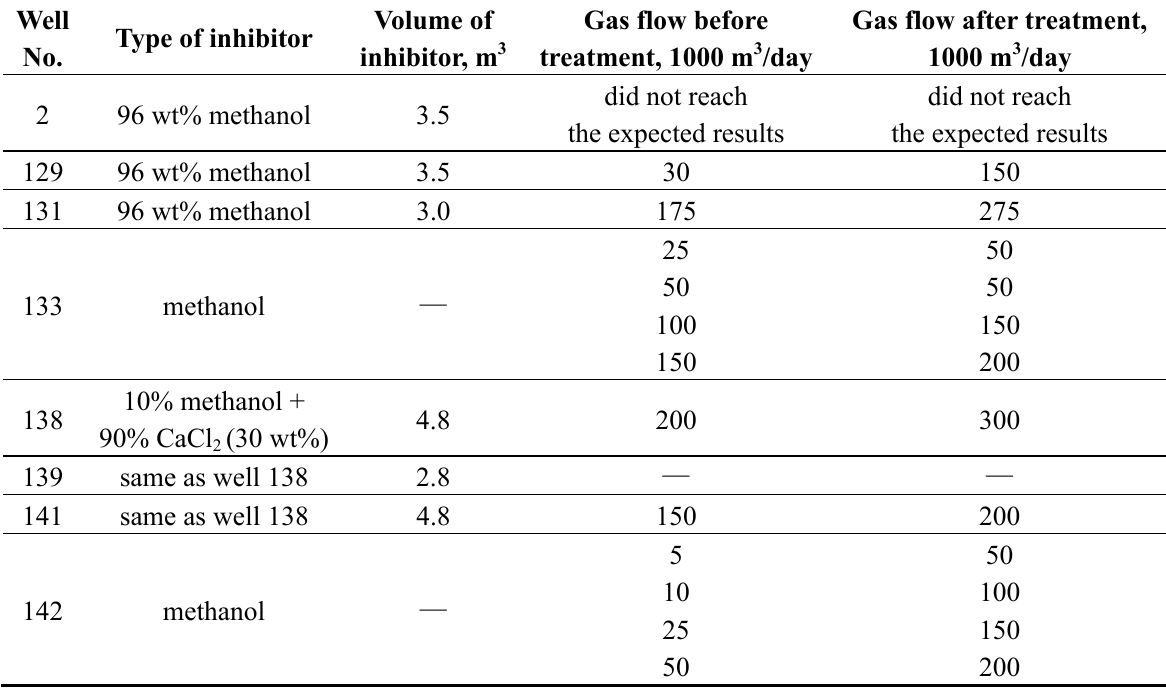
Table 4. Experimental results of gas production from the Messoyakha gas hydrate reservoir [42].